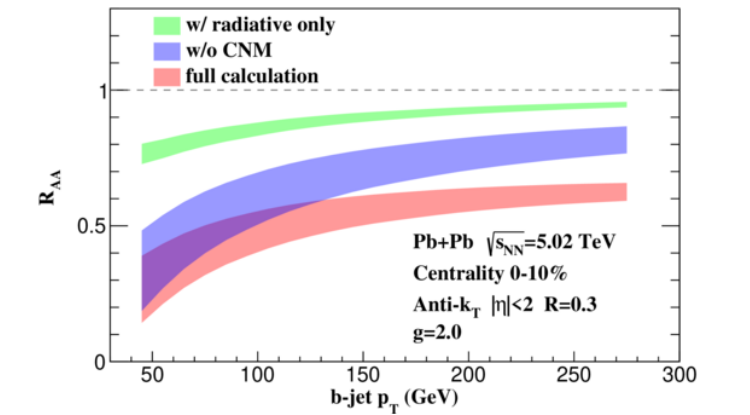
Figure 5 . The b-jet suppression factor for central Pb+Pb collision at √ s algorithm with R=0.3 and jet anti-k η < 2 are implemented. The R AA with all nuclear effects T | | included is shown as the red band. The blue band presents the prediction without the CNM effects, while the green band corresponds to the result with only in-medium radiative processes included.